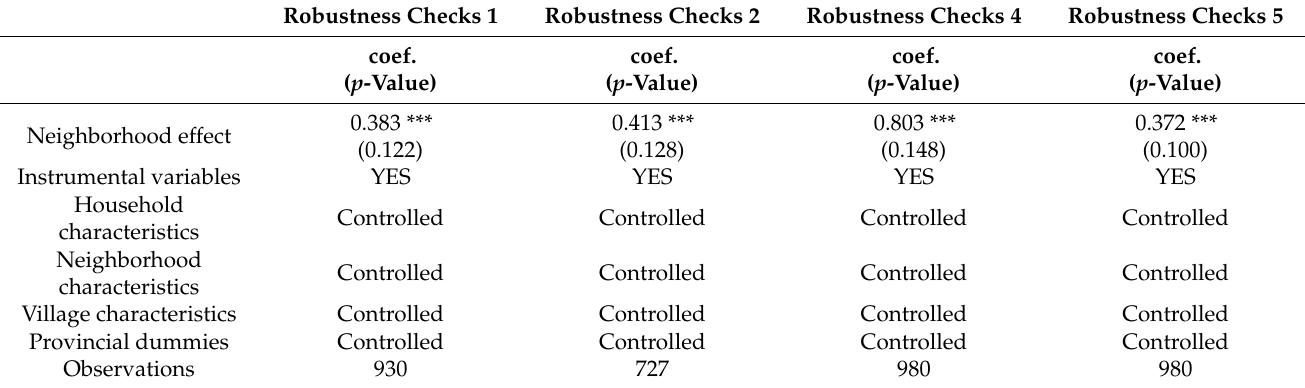
Table 3. Robustness checks of the neighborhood effect on farmers’ adoption